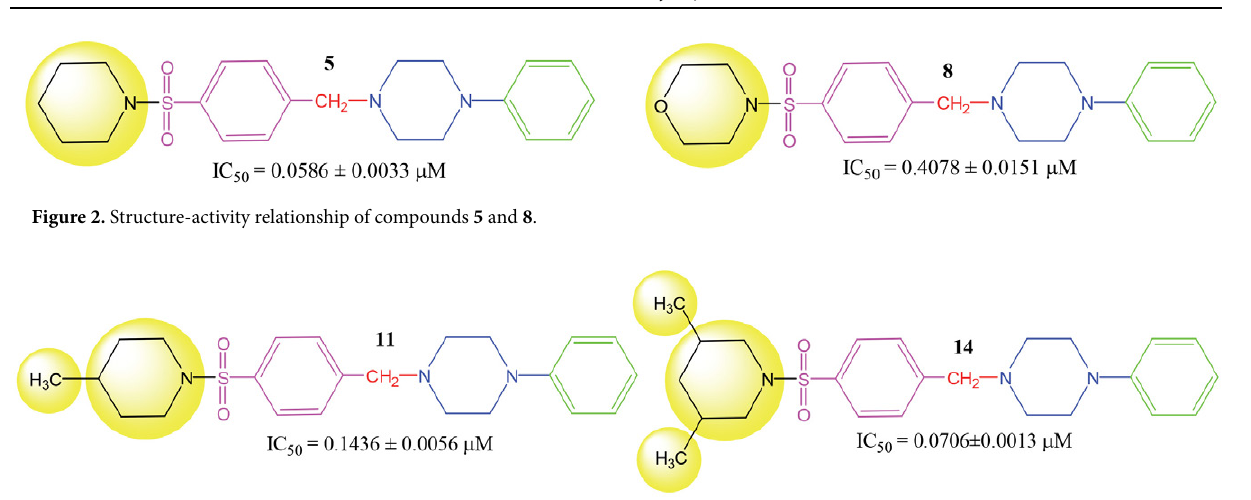
Figure 3. Structure-activity relationship of compounds 11 and 14 .